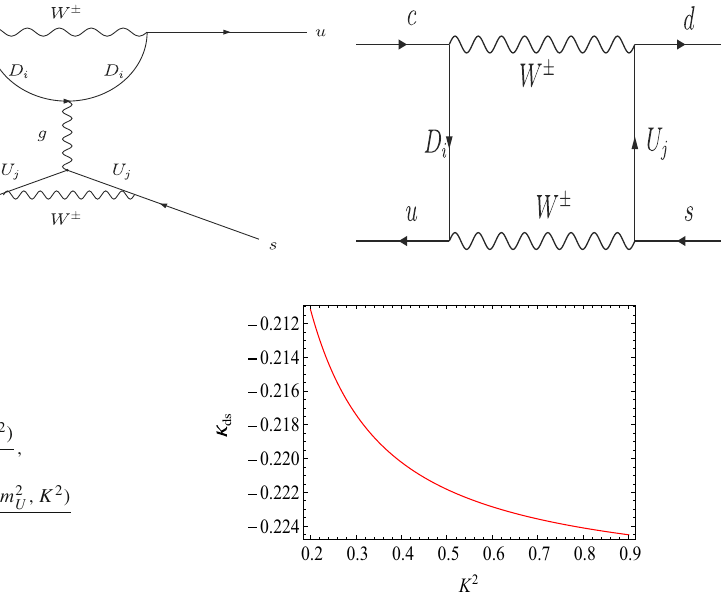
Fig. 2 Variation of κ ds with K 2 smaller than G F α S /( 9